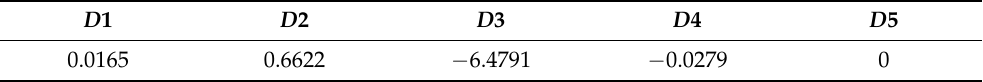
Table 4. Johnson–Cook damage model parameters for SBPR 930/1080 Type B No.